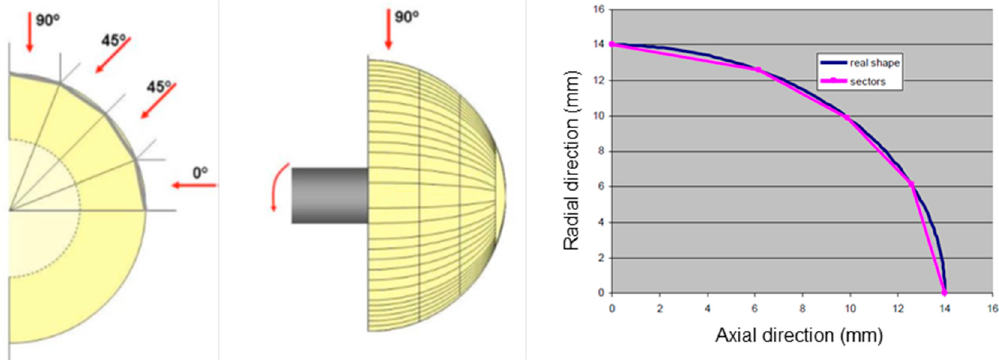
Figure 4. Schemes showing how the ceramic cup was processed by laser treatment.